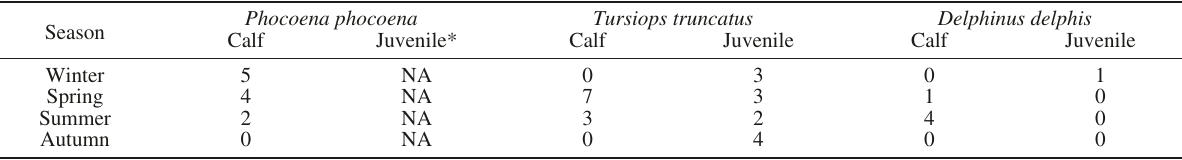
Table 3. – Number of sightings of young animals during the land-based observations. * Only one category of young animals (calves) was recorded for the harbour porpoise because the remaining age categories are difficult to distinguish reliably from the shore.